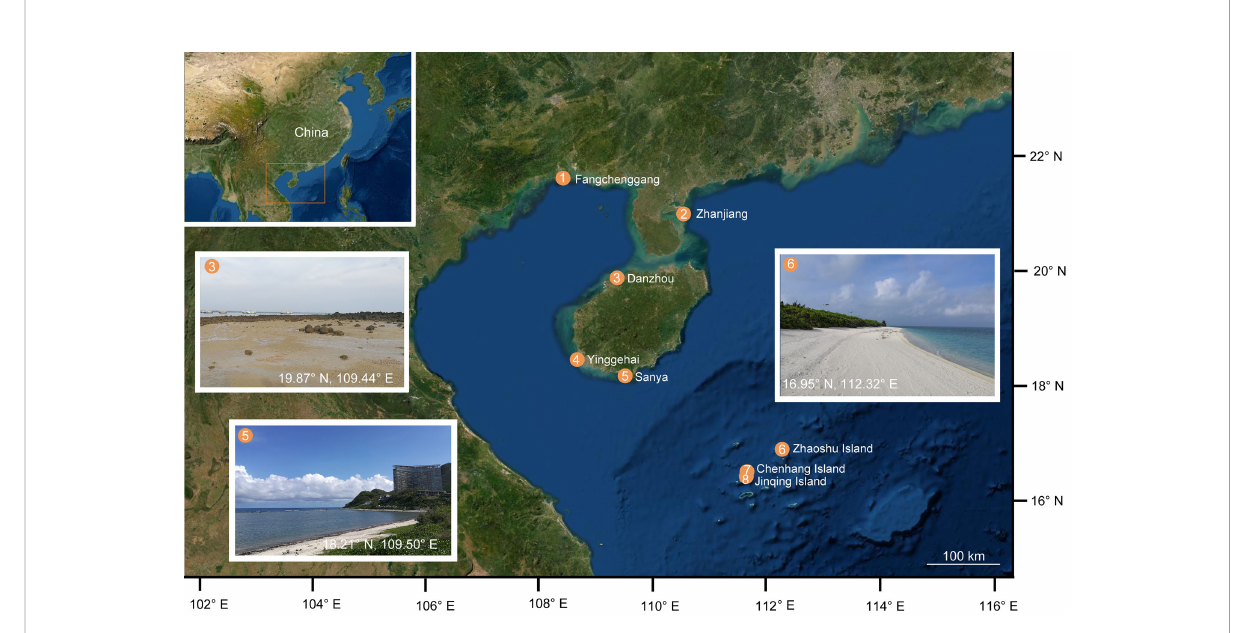
FIGURE 1 Map and photographs showing sampling sites and